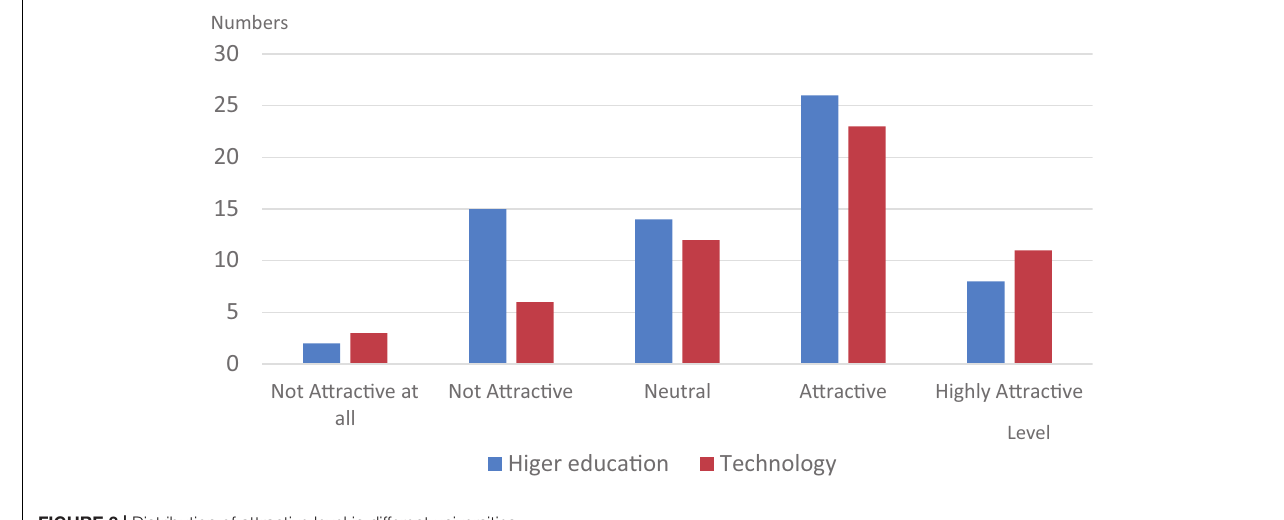
FIGURE 3 | Distribution of attractive level in different universities.